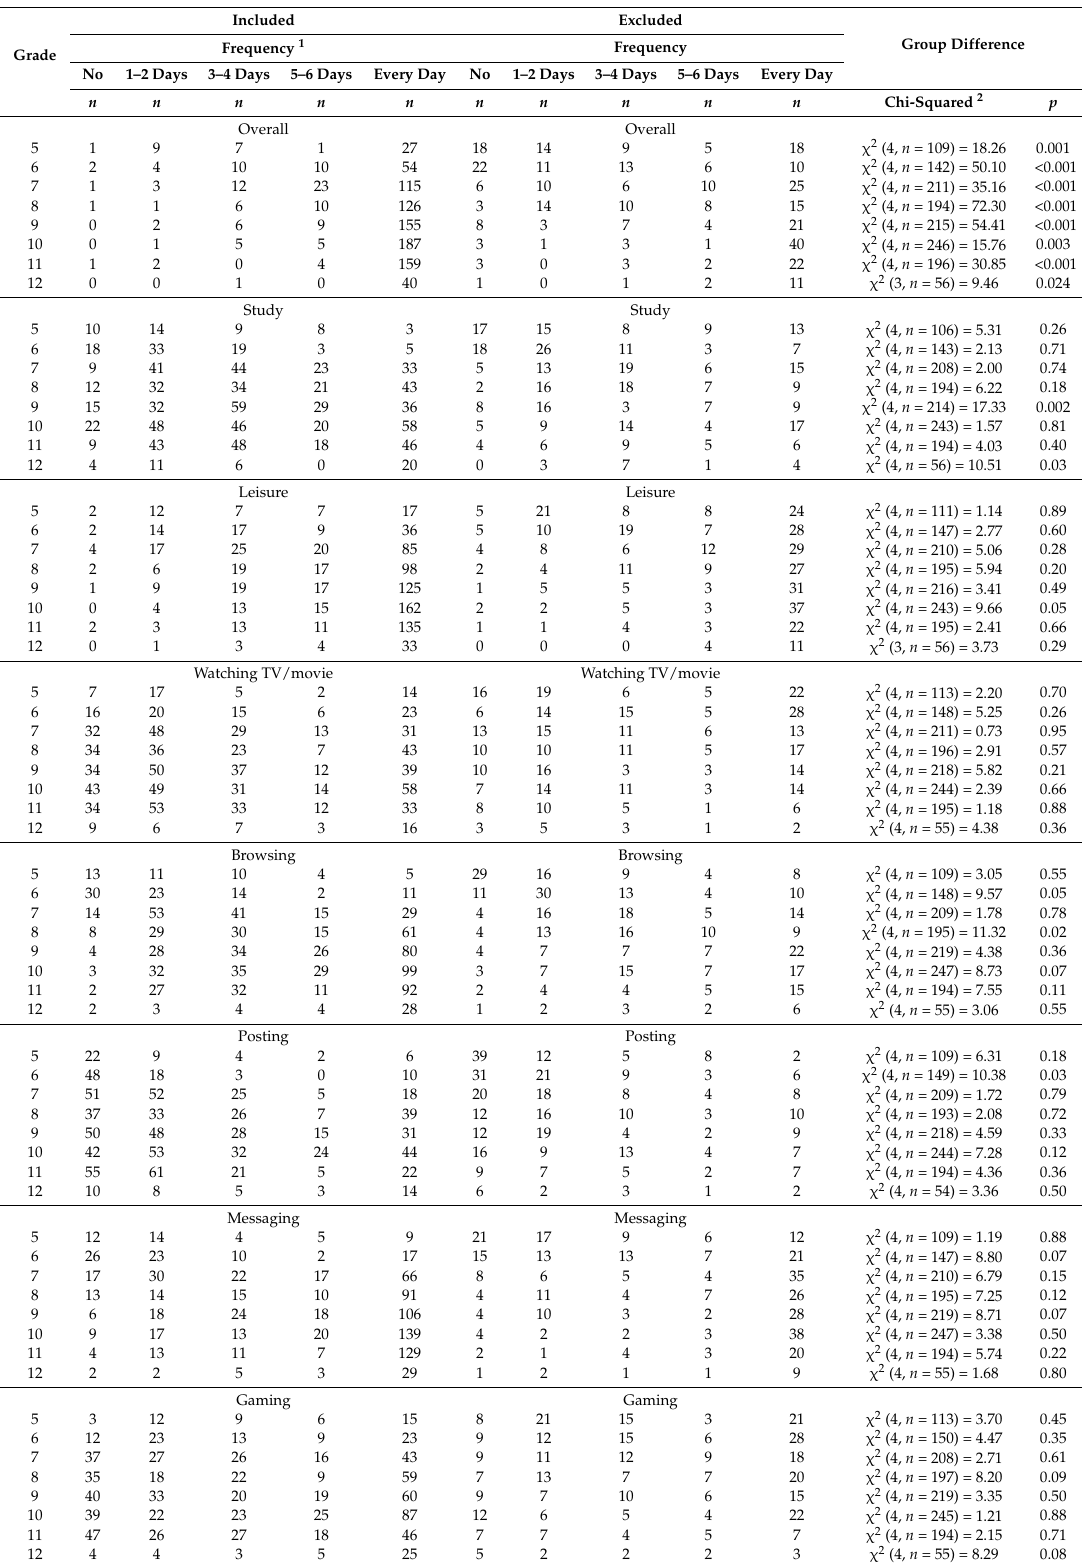
Table A4. Differences in frequencies of smart device activities, overall use and its purposes between included and excluded respondents by